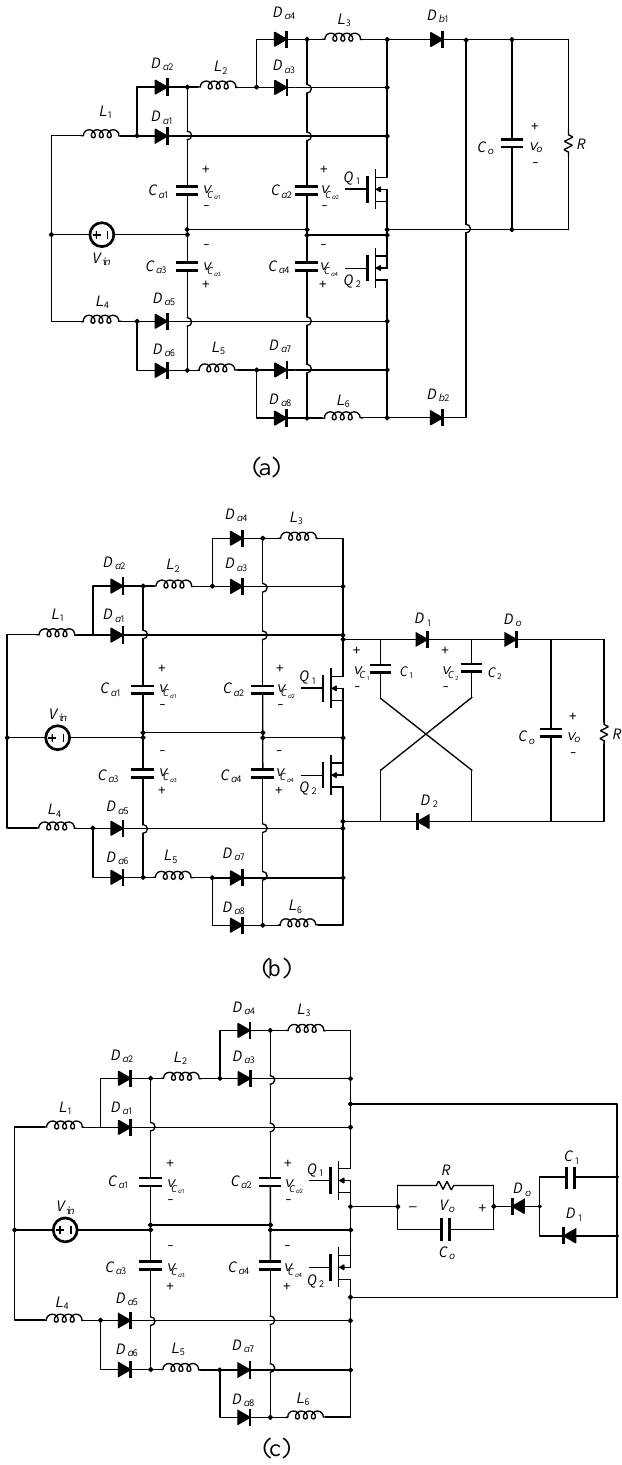
Figure 3. Different variations of the proposed converter ( a ) Schematic of the proposed converter with 3 stages (cubic) and no voltage multiplier cell (VMC), ( b ) another interleaved cubic boost converter with one stage of cross capacitor VMC, and ( c ) interleaved cubic boost converter with one Cockcroft-Walton